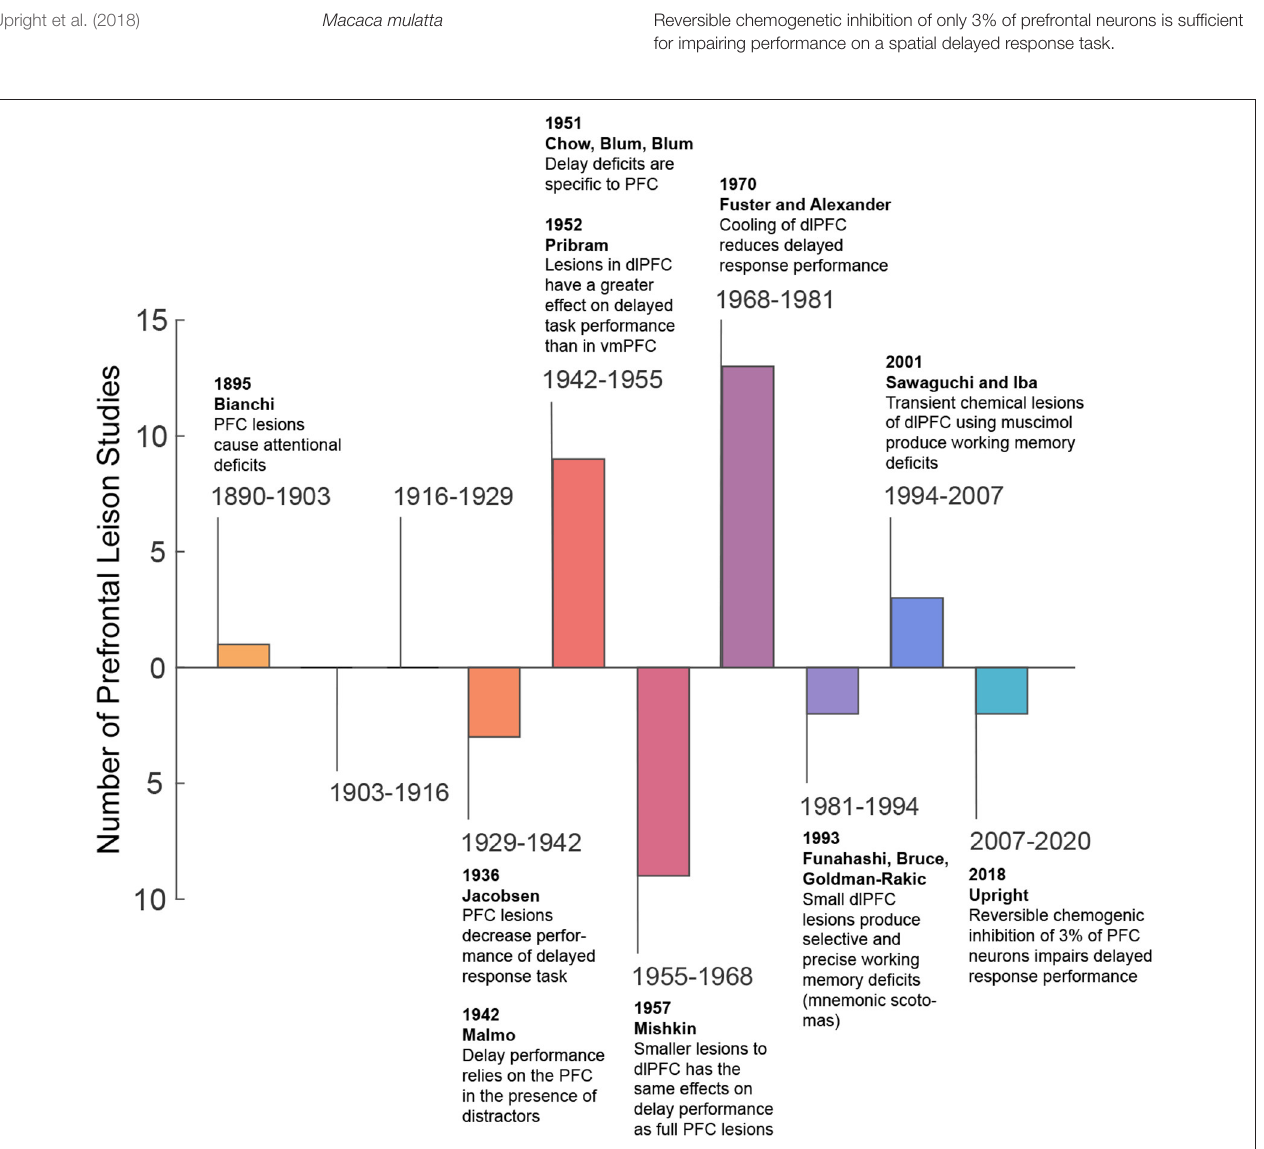
FIGURE 1 | Summary of lesion studies.